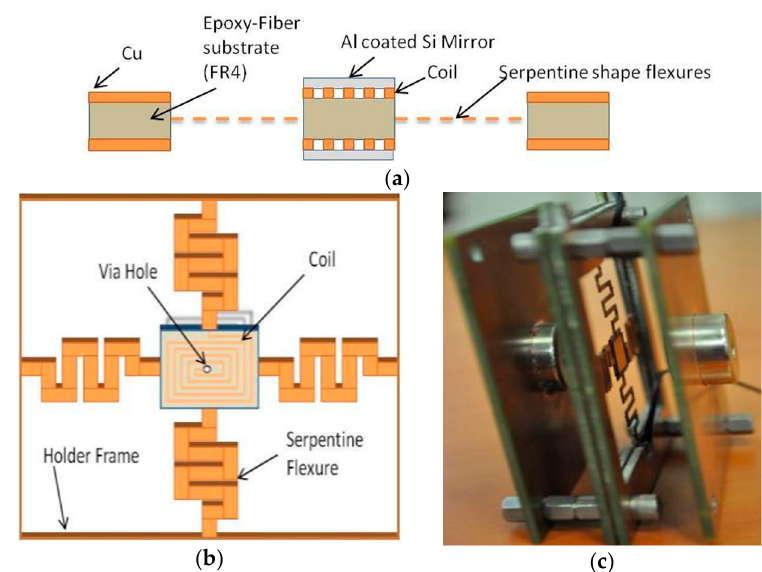
Figure 21. Design of the FR4 Lorentz-type electromagnetic actuator: ( a ) Side view of the system; ( b ) top view of the system; ( c ) fully assembled device. (Reprinted with permission from Reference [45] AMER SOC MECHANICAL ENGINEERS).